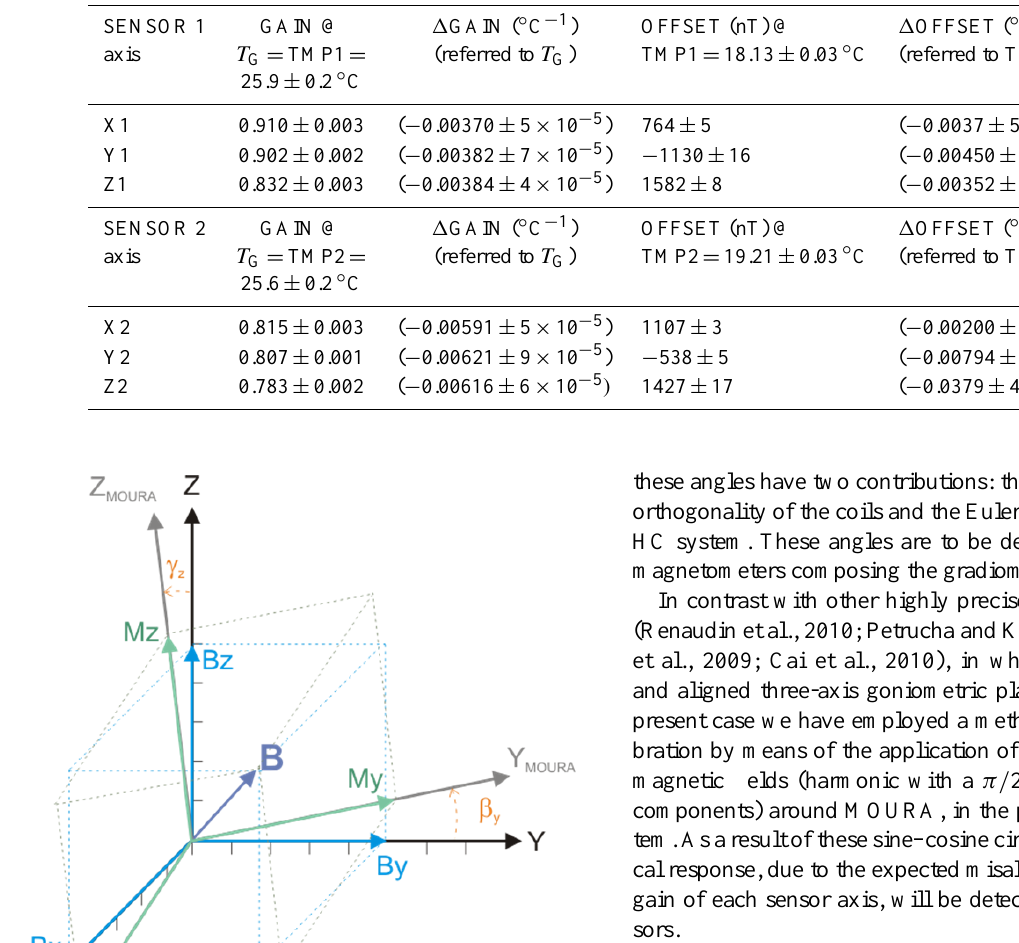
Table 5. Gains and offset values as well as their temperature drifts.